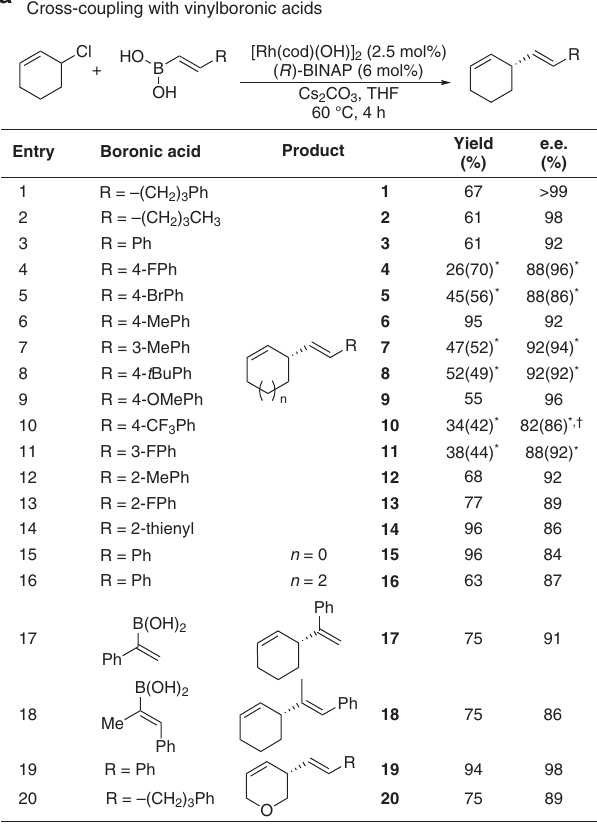
. At the end of the legend for Fig. 2, the following sentence has been added: ‘**Reaction using ( S )-BINAP and stirred at room temperature 48 h.’